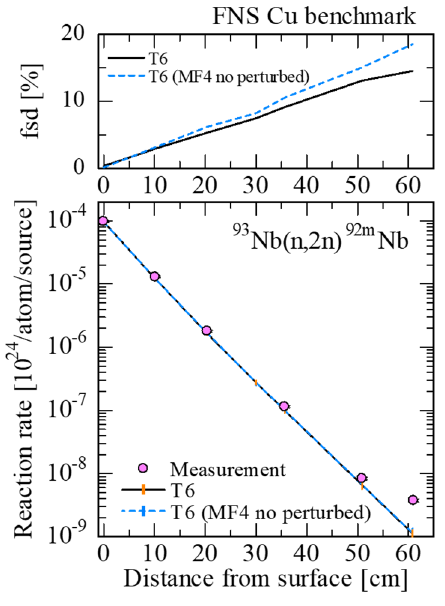
Fig. 6. Comparison of 93 Nb(n,2n) 92m Nb reaction rate distribution and the standard deviation between T6 and the result ignoring perturbation of angular distribution.